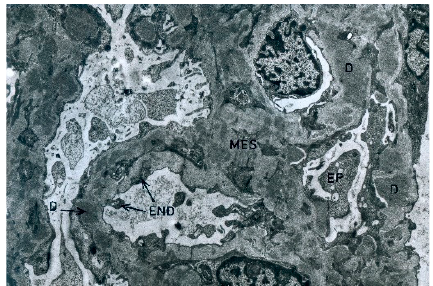
Figure 7. The case of C3GN. Electron microscopic image of the glomerulus with transposition of mesangial cell protrusions to the periphery of the capillary loop and presence of subepithelial deposits. Electron microscopy, 8750× magni fi cation. Mes, mesangium; EP, epithelium; END, endothelium; D, deposits.